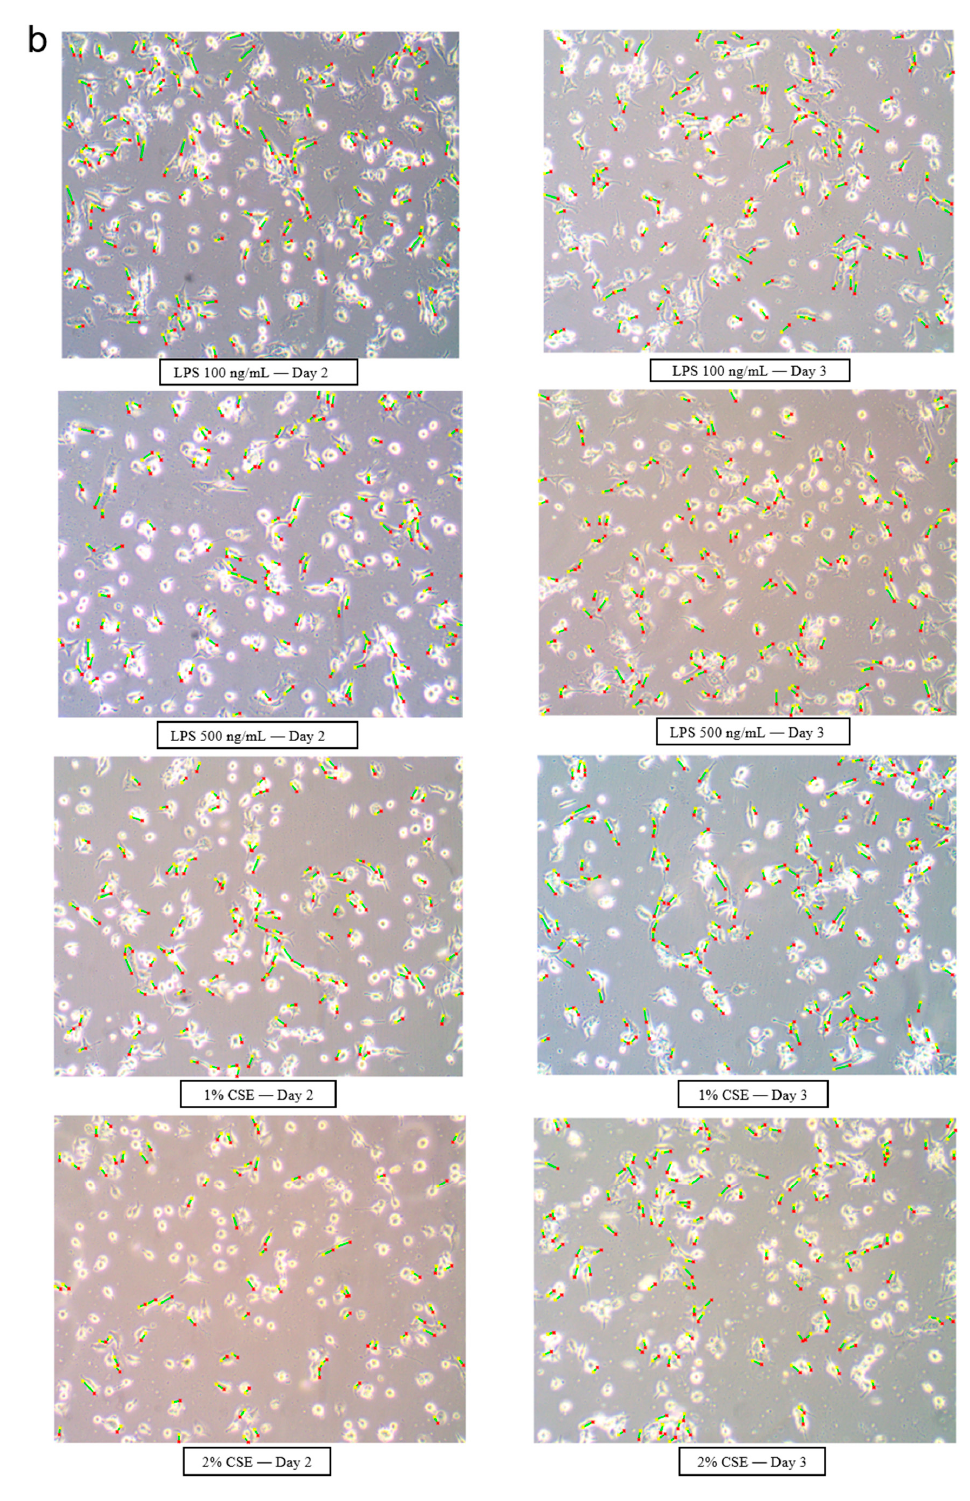
Figure 5. Morphological analysis of A549 cells using image processing techniques. The original pictures were obtained by optical microscope (200× magnification). ( a ) Representative images of A549 cells in the control and TGF- β groups from days 0 to 3. ( b ) Representative images of A549 cells in LPS (100 and 500 ng / mL) and CSE (1% and 2%) groups on days 2 and 3 (green: cell length; red: start point; yellow: end